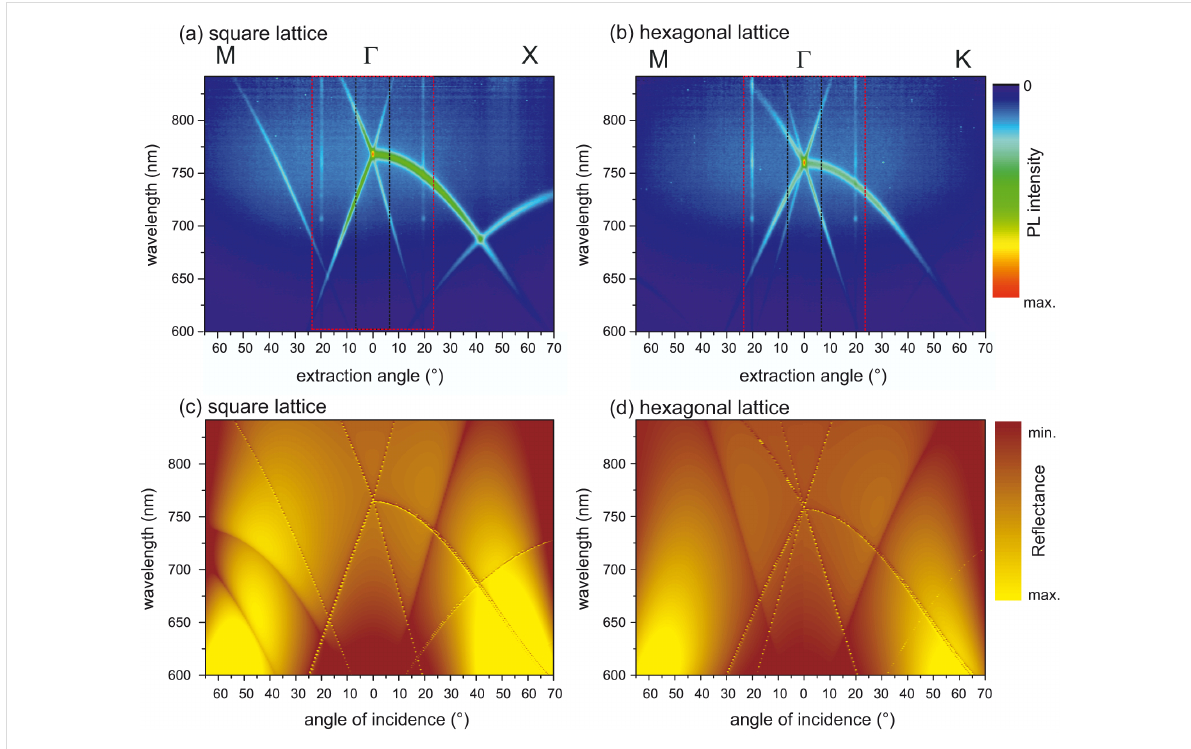
Figure 3: Angle-resolved PL spectra of the PhCs with h PhC2 on the SiNC-rich layer measured along the relevant directions of high symmetry. As an example, spectra of the PhCs with the “blue” lattice constants, namely (a) square lattice ( a = 525 nm) and (b) hexagonal lattice ( a = 600 nm) are shown. The rectangles plotted with black and red dashed lines depict the collection half angles covered with the NA = 0.12 and NA = 0.4 objectives, respectively, used in the micro-PL setup. Angle-resolved spectra of the other fabricated PhCs are given in Supporting Information File 1. Note: The vertical (intensity) lines visible in the plots at around 20° for all high-symmetry directions are artifacts of the measurement caused by the laser light entering directly into the detection fiber. (c, d) Simulated leaky modes photonic band diagrams of the square-lattice and hexagonal-lattice PhCs in panels (a) and (b), respectively. The band diagrams were obtained from simulated reflectance spectra of the